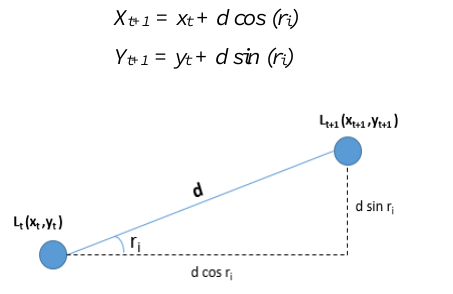
Figure 3. Position calculation for inertial navigation Figure SEQ Figure \* ARABIC 3: Position calculation for inertial